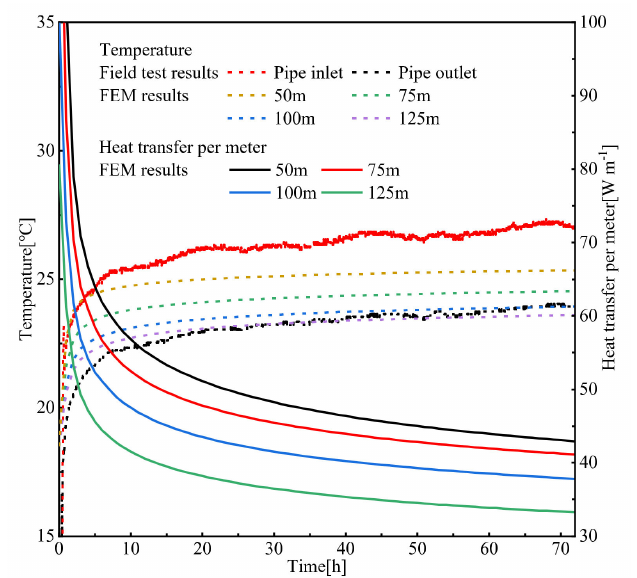
Figure 12. The variation curve of outlet temperature and unit heat exchange of #1 pile under different well depth conditions (3.5